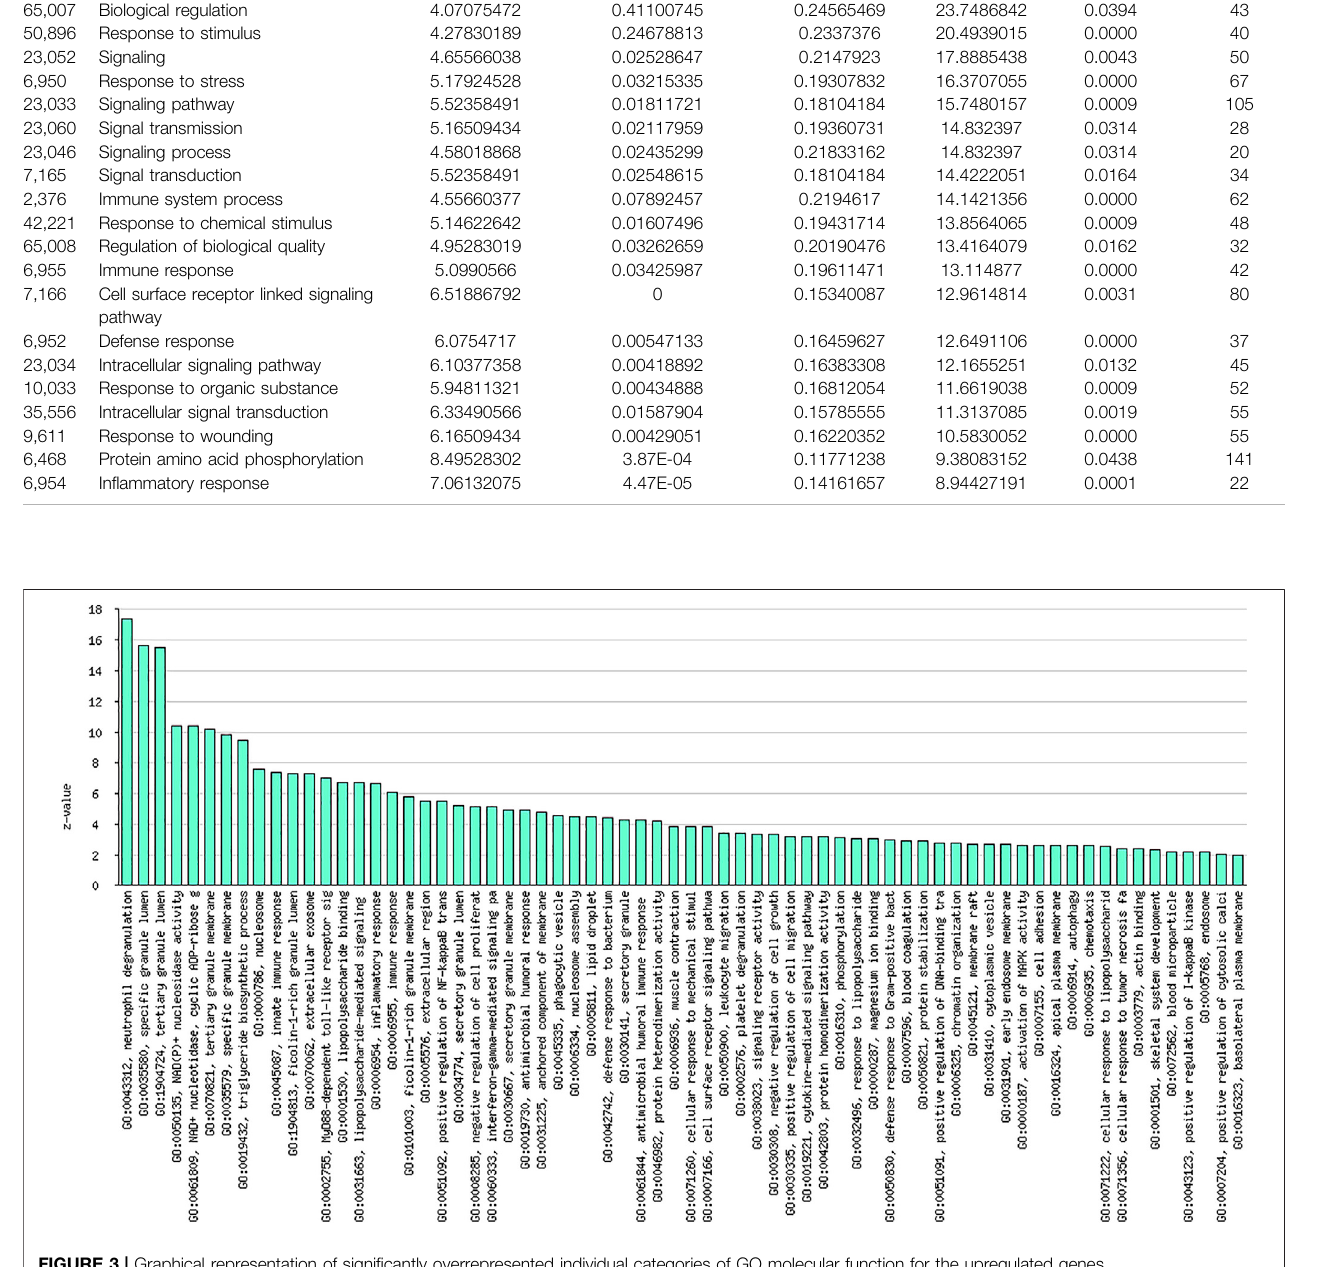
Frontiers in Genetics |